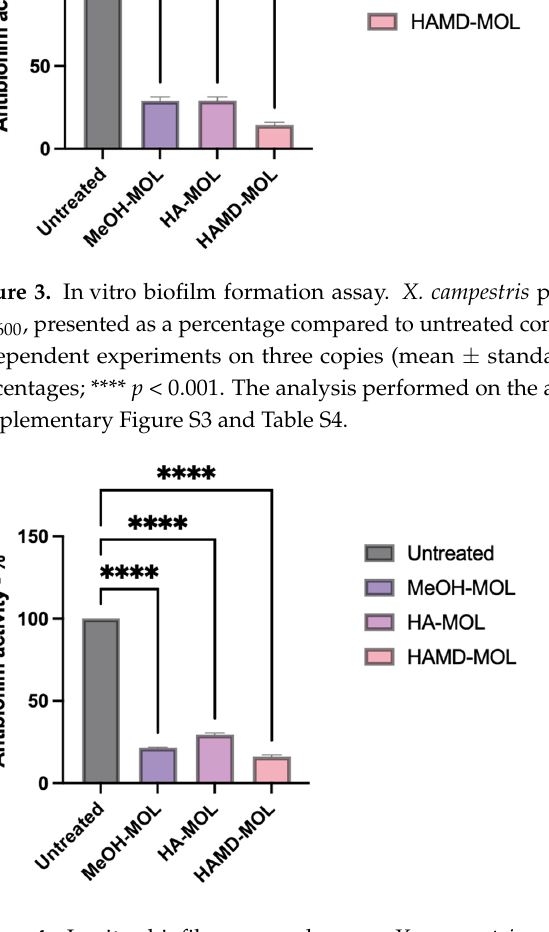
Figure 4. In vitro biofilm removal assay. X. campestris pv. campestris biofilm was measured by OD 600 , presented as a percentage compared to untreated control. Data represent the average of three independent experiments on three copies (mean ± standard deviation), and values are given as percentages; **** p < 0.001. The analysis performed on the activity of single strains can be found in Supplementary Figure S4 and Table S5.